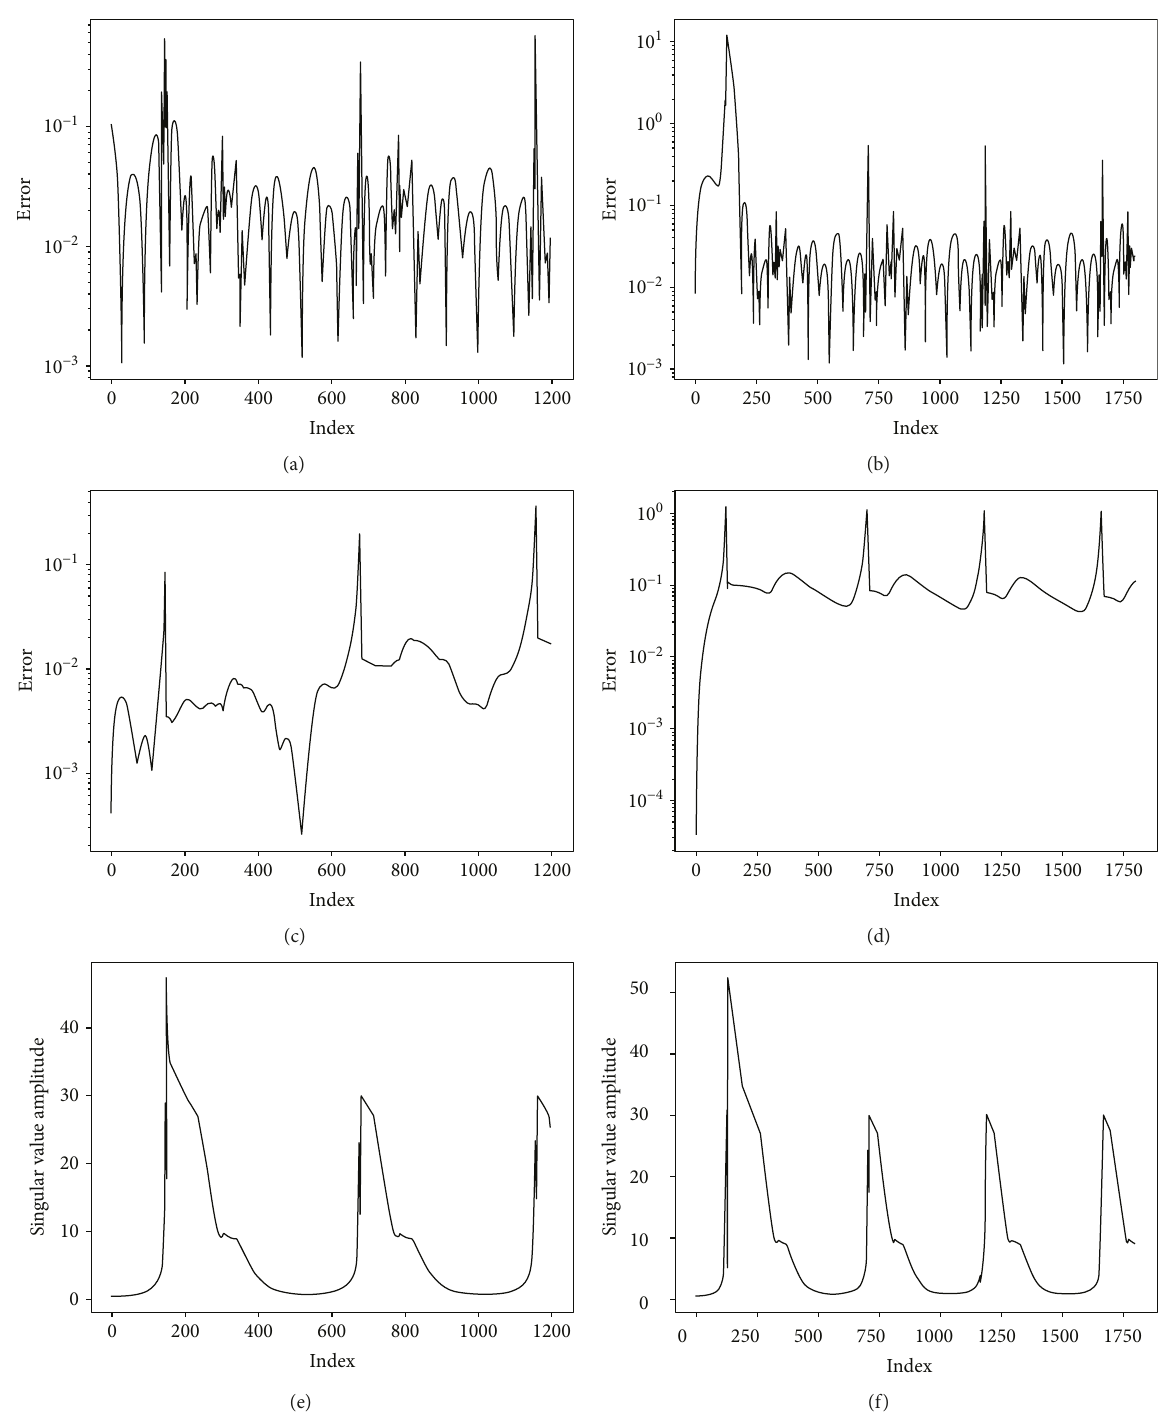
Figure 9: Variation of local error and global error: basic model on nonrational, nonpolynomial case. (a, b) Local error. (c, d) Global error. (e, f) Maximal singular value of the Jacobian evaluated in a priori. (a, c, e) Training data. (b, d, f) Testing